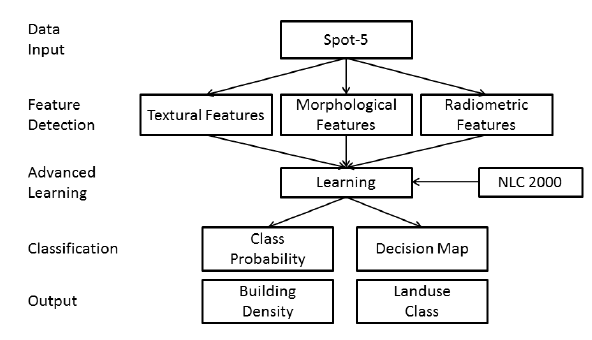
Figure 2. GHSL South Africa workflow